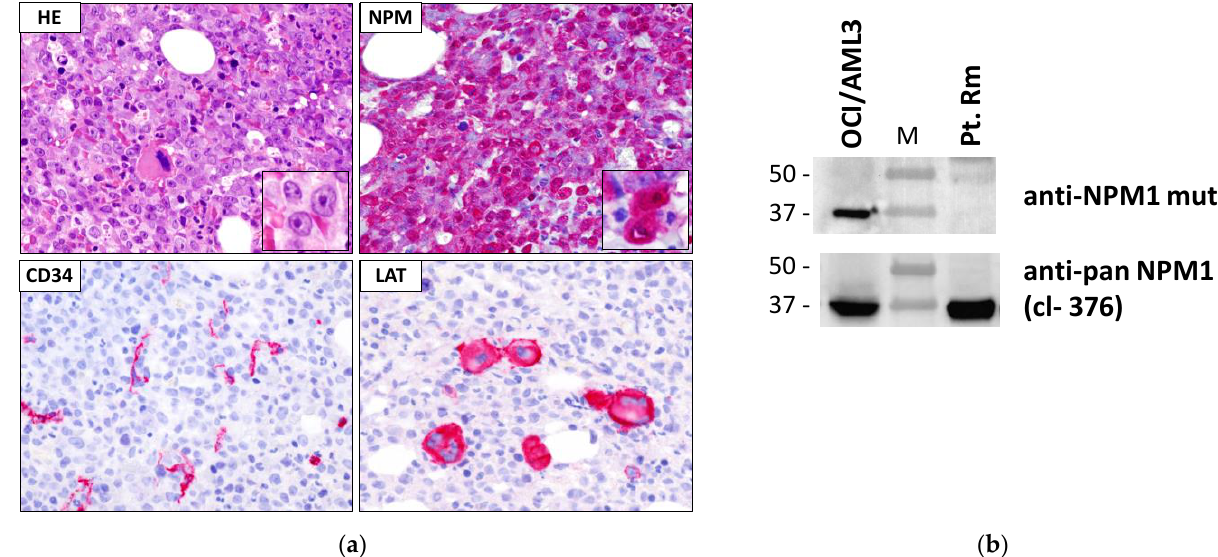
Figure 2. ( a ) Immunohistochemical staining of bone marrow trephine from pt. Rm. HE: hematoxylin-eosin staining; NPM: mouse monoclonal anti-panNPM1, clone 376; CD34: anti-CD34 mAb (to note, blood vessels in tissue sections are used as positive control for CD34 staining). LAT: linker for activation of T cell (marker for megakaryocytes); APAAP technique; hematoxylin counterstaining. Images were collected using an Olympus B61 microscope with a UPlanApo 40×/0.85U and UPlan FI 100×/1.3 NA oil objective for the insets; Camedia 4040, Dp_soft Version 3.2; and Adobe Photoshop CC 2019; ( b ) WB analysis of total protein extracts from pt. Rm. OCI/AML3: positive control for NPM1 mutant A expression. M: molecular weight marker.